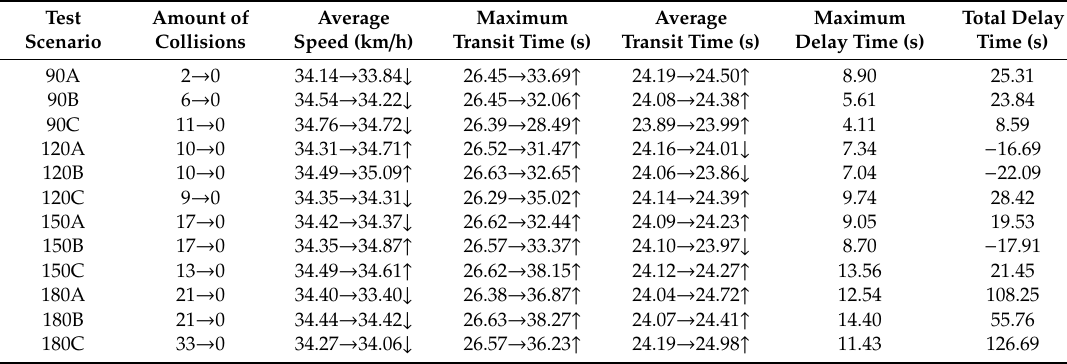
Table 7. Evaluation indexes of the solutions for the 12 test